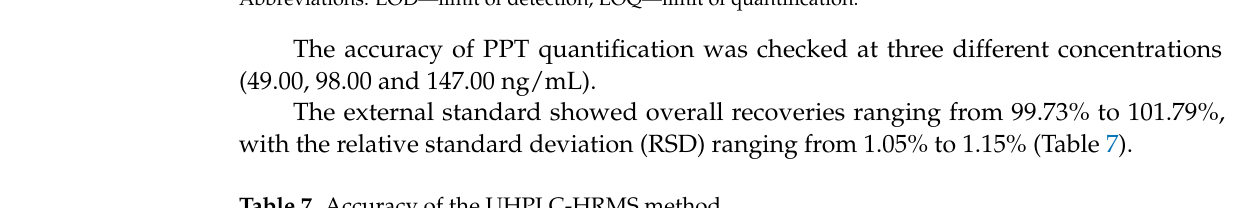
Table 7. Accuracy of the UHPLC-HRMS method.